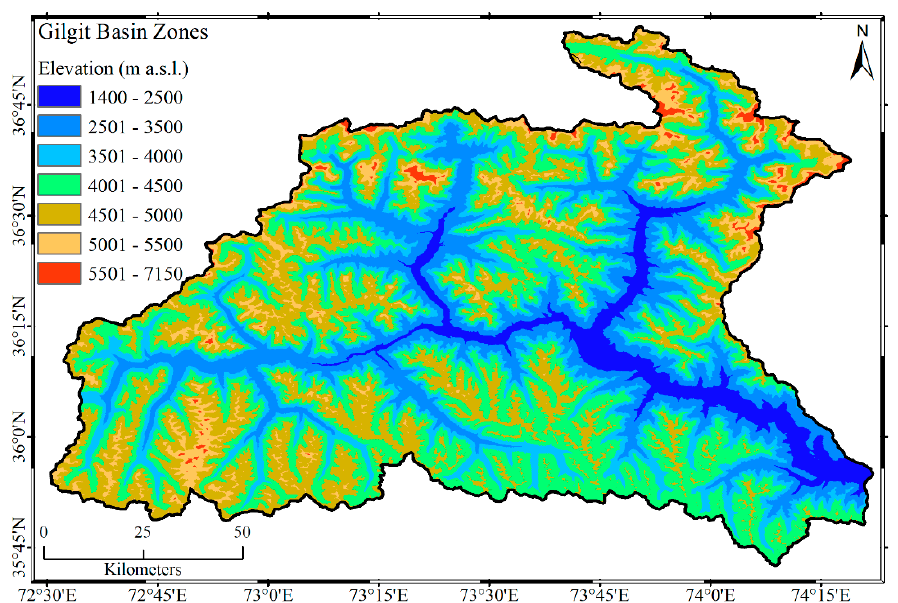
Figure 3. Digital Elevation Model of Gilgit River Basin illustrating the seven delineated zones.